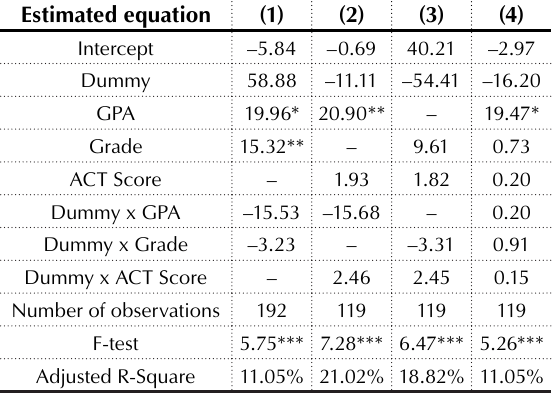
Table 4. Regression results with the second mid- term exam scores (EXAM2) as the dependent variable